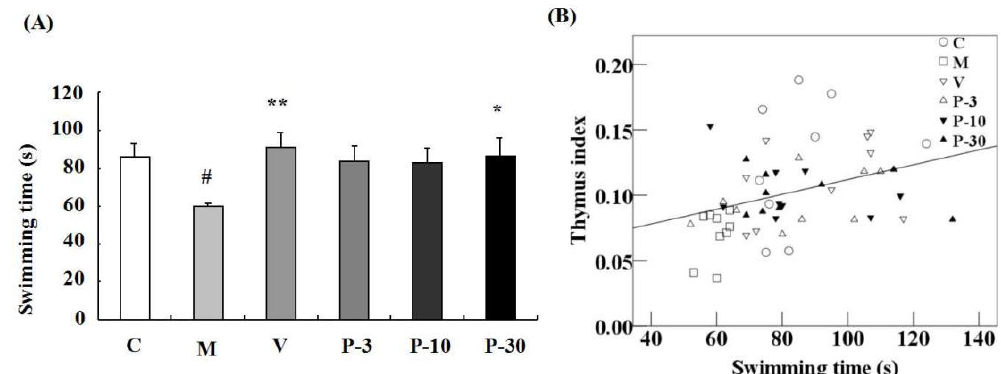
Figure 5. PAE e ff ects on d -gal-induced fatigue in the weight-loaded forced swimming test (WLFST) and Pearson’s correlation between the swimming time versus thymus coe ffi cients. The mice were individually placed into the plastic pool which containing freshwater. The mice were forced to swim in the water until exhaustion. The time that the mice were unable to keep their nose out of the water for 5 s was recorded as the exhausted swimming time. ( A ) The swimming times in the WLFST were recorded. Results are presented as mean ± SEM. n = 9, ## p < 0.01 vs. vehicle control group and * p < 0.05, ** p < 0.01 vs. d -gal-treated group in the WLFST. ( B ) Pearson’s correlation between the swimming time versus thymus coe ffi cients was determined. C (hollow circle), M (hollow diamond), V (inverted hollow triangle), P-3 (hollow triangle), P-10 (inverted filled triangle), P-30 (filled triangle), n =